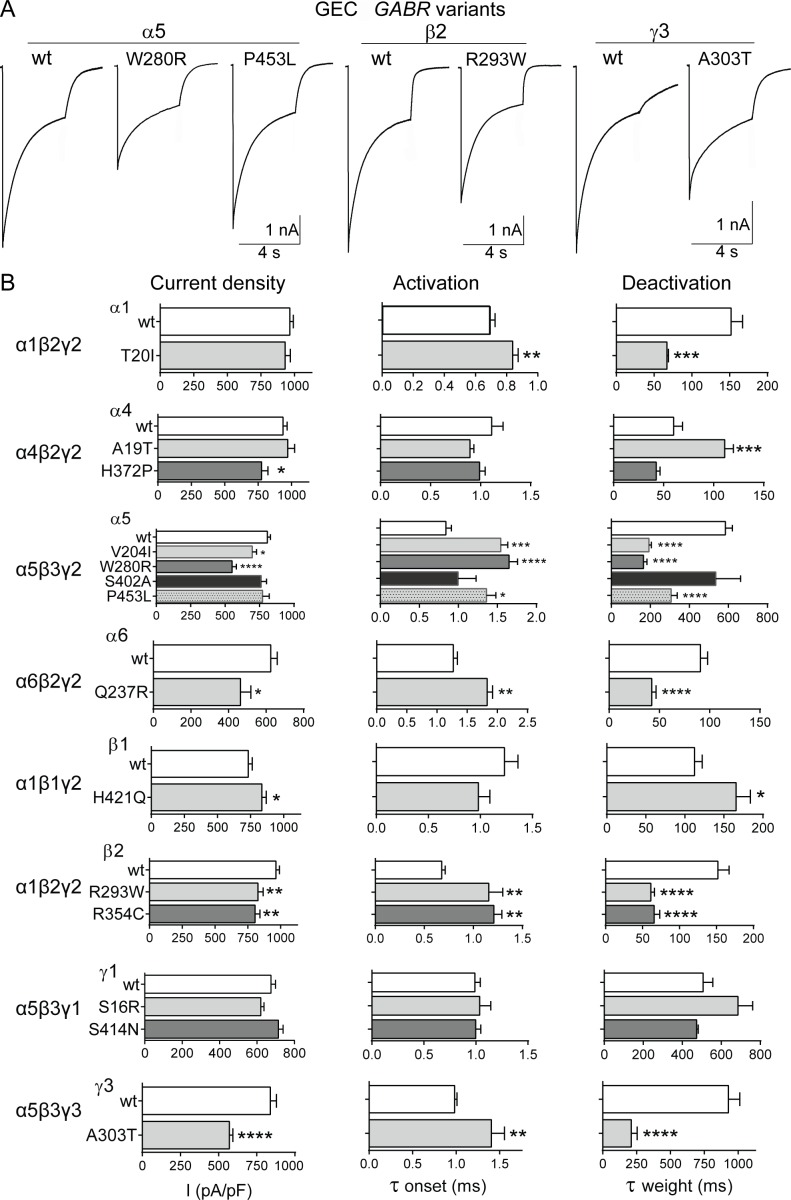
Deleterious GEC GABR variants caused major reductions of GABA-evoked currents.(A), Representative current traces from wild type (wt) and variant subunit-containing receptors are shown. The variants α5W280R, α5P453L, β2R293W, and γ3A303T were scored as deleterious by PolyPhen-2. GABA-evoked currents are the result of 4 s pulses of 1 mM GABA of cells expressing α5β3γ2, α1β2γ2, and α5β3γ3 GABAA receptors, respectively. (B), Bar plots summarize the effects of wild type and GEC subunit variants on macroscopic parameters of GABAA receptor currents. GABAA receptor composition is indicated on the left. Values were expressed as mean ± S.E.M. *, **, *** and **** correspond to p < 0.05, p < 0.01, p < 0.001 and p < 0.0001 (unpaired t test or one-way ANOVA with Dunnett’s multiple comparisons test) statistically different from wild type (see Table 5 for details).